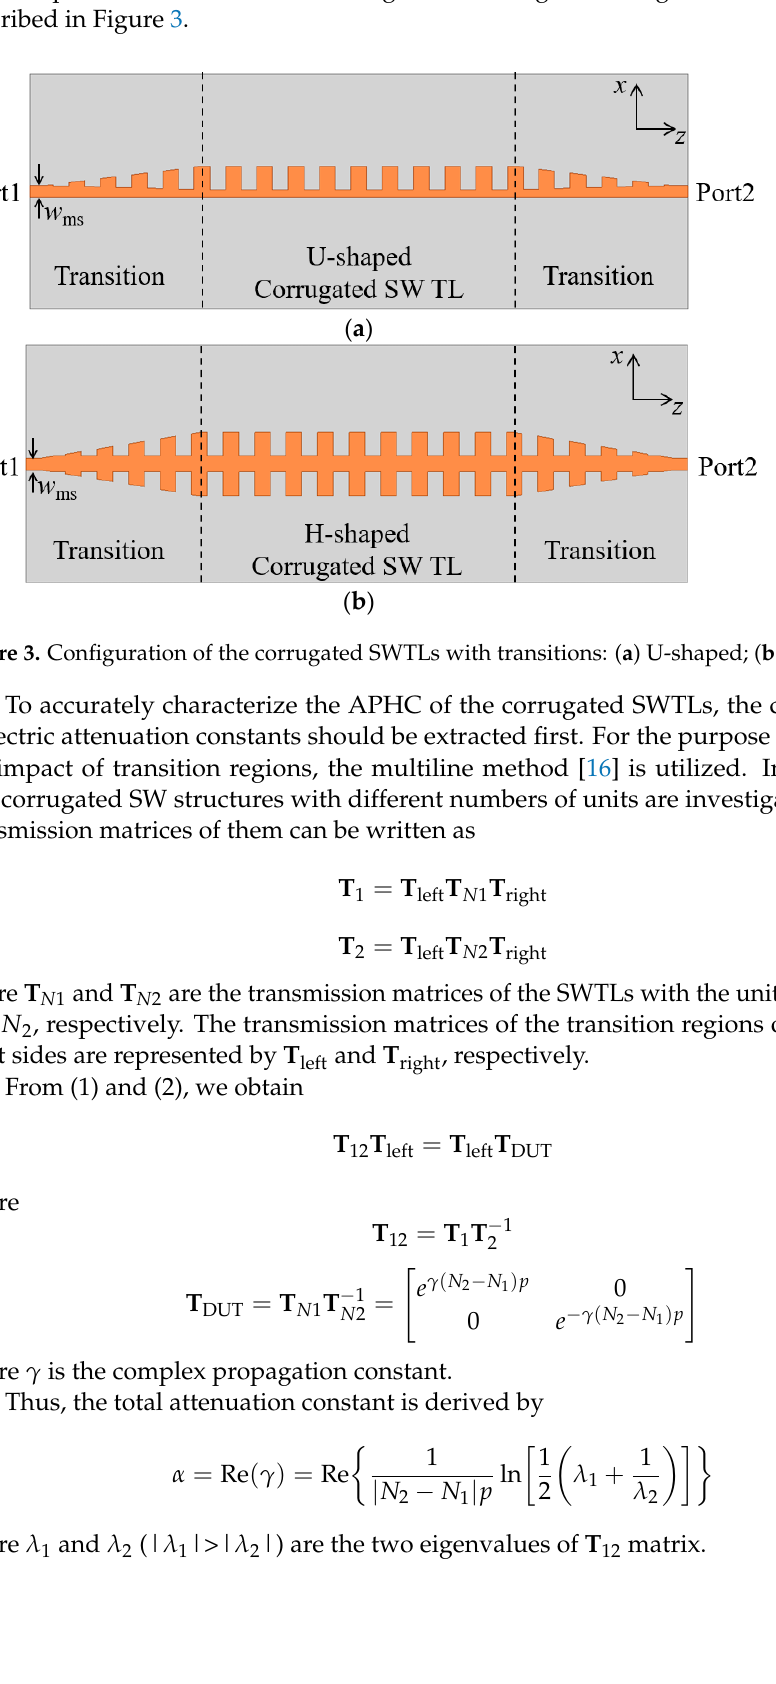
Figure 2. Dispersion curves of the corrugated SWTLs.